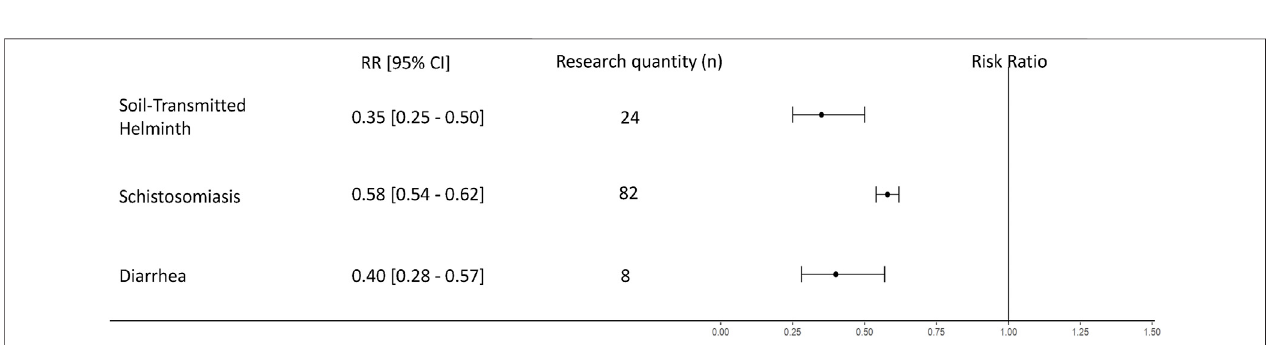
Frontiers in Environmental Science |